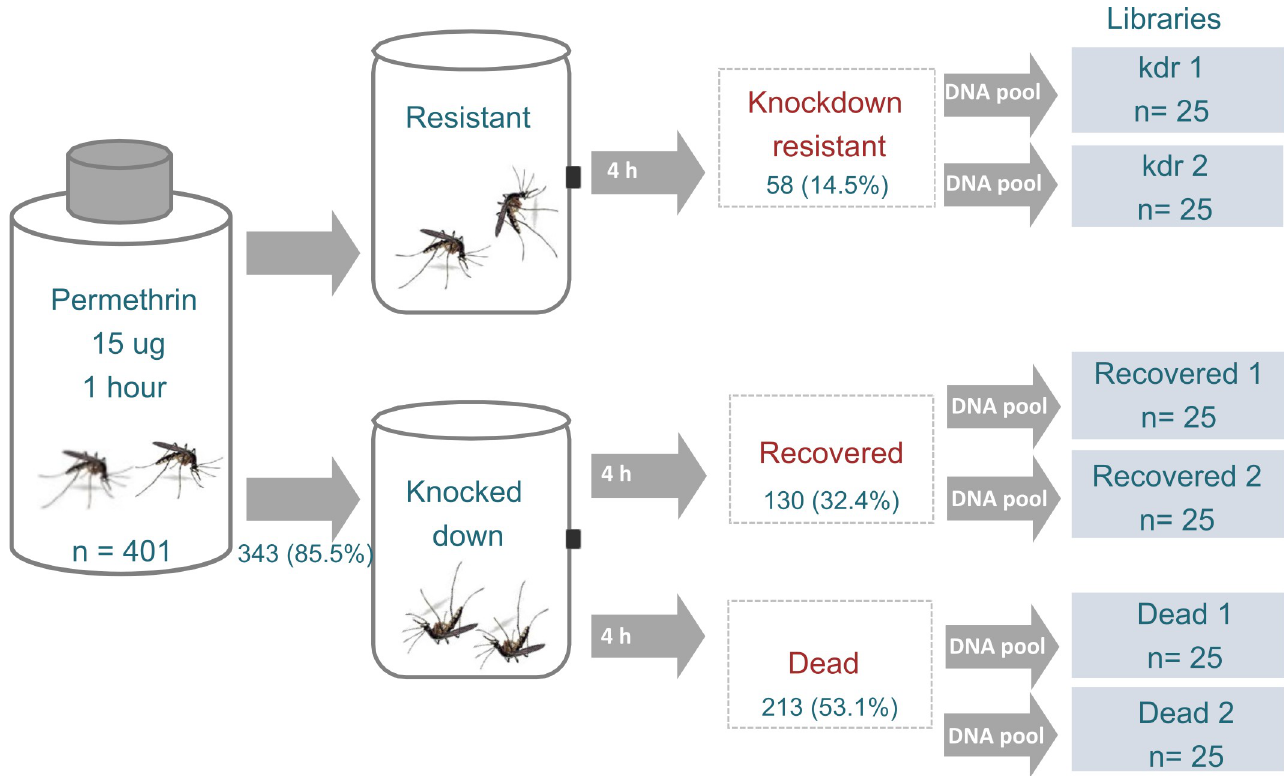
Fig 1. Bioassay to differentiate three phenotypes in Aedes aegypti exposed to permethrin (15 ug/bottle) for 1 h. Total number of mosquitoes used in bioassays are shown. Pooled libraries were prepared using 25 individual mosquitoes from each phenotypic group. https://doi.org/10.1371/journal.pgen.1009606.g001 sites, 7.5% at 5’-UTR sites, 36.9% at synonymous coding sites, 9.6% at nonsynonymous coding sites, 37.8% at intron sites, and 0.6% in noncoding RNA. The mean LODs for SNPs belonging to three gene categories associated with insecticide resistance (cuticle, detoxification, and insecticide target sites) are shown in Table 1. For the cuticle category, the mean LODs were not significantly different between the phenotypes (F = 1.67, p value = 0.18). However, the mean LODs were significantly different for the target site category (F = 50.5, p value = 2e-16), in which the kdr vs recovered and kdr vs dead had mean LODs of 8.69 and 14.3, respectively, while the recovered vs dead comparison had a mean